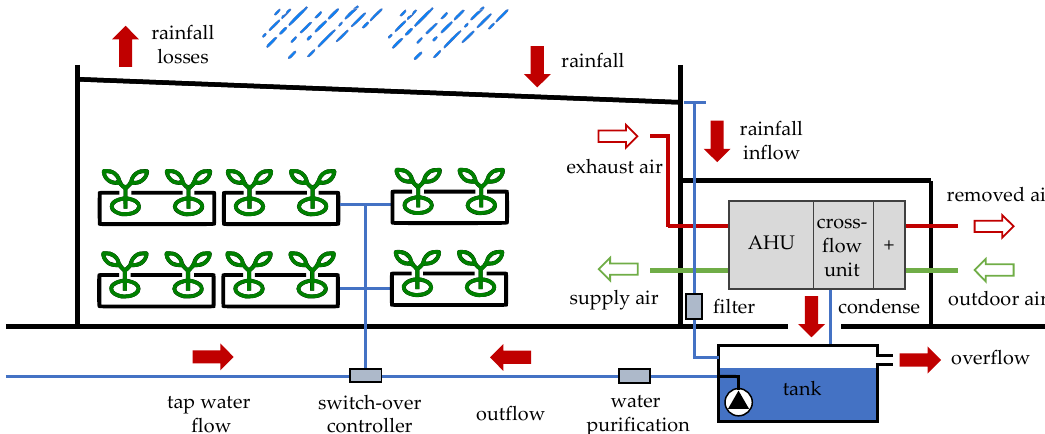
Figure 3. The diagram of the water flow in the rainwater harvesting system cooperating with water recovery from the exhaust air.